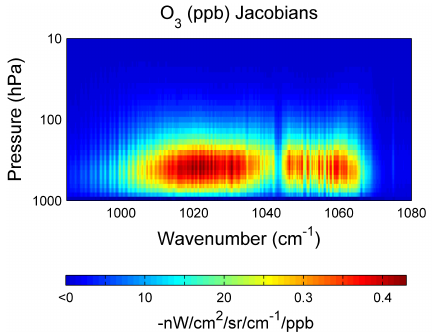
Figure 1. Example of O 3 Jacobians for a single observation in the 9.6µm spectral band, with respect to ozone in ppb for an ob- servation taken on 15 January 2011, at (51.13 ◦ N, 42.3 ◦ W) and 04:57UTC and for 47.48 ◦ viewing